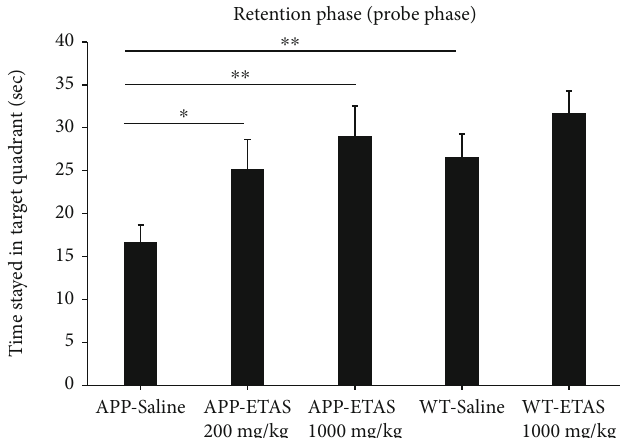
Figure 2: Representation of time stayed in target quadrant (probe phase), 7 days after removing the platform in APP-overexpressed mice treated with ETAS (200mg/kg and 1000 mg/kg), respectively, and WT mice treated with ETAS (1000mg/kg) ( n = 10 mice in each group). ∗ p < 0 : 05 APP-ETAS (200mg/kg) vs. APP saline-treated mice; ∗∗ p < 0 : 01 APP-ETAS (1000mg/kg) vs. APP saline-treated mice; ∗∗ p < 0 : 01 WT saline vs. APP saline-treated mice; Sec: